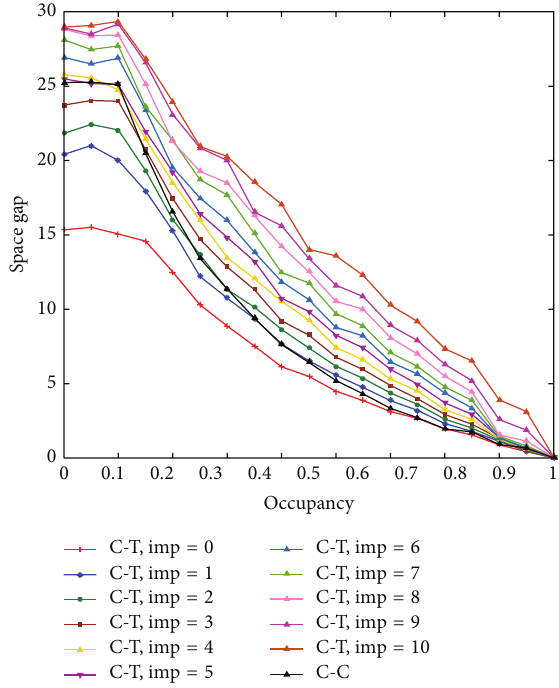
Figure 8: The relationship between the space gap of C-T and occupancy under different imp when 𝑟 = 0.2